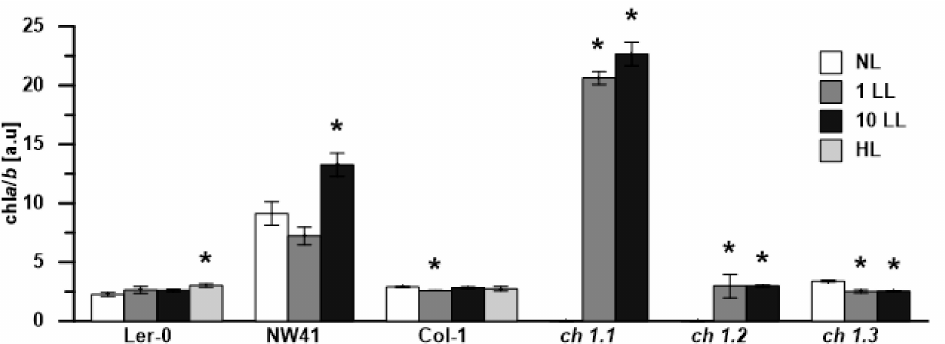
Figure 7. Changes in the Chla/b ratio in thylakoids isolated from all analyzed plants in NL (normal light), LL (low-light) and HL (high-light) conditions. The data were obtained by HPLC analysis. The data are mean values ± SD from 3 independent experiments; results marked with an asterisk differ significantly at p = 0.05 from each plant in NL